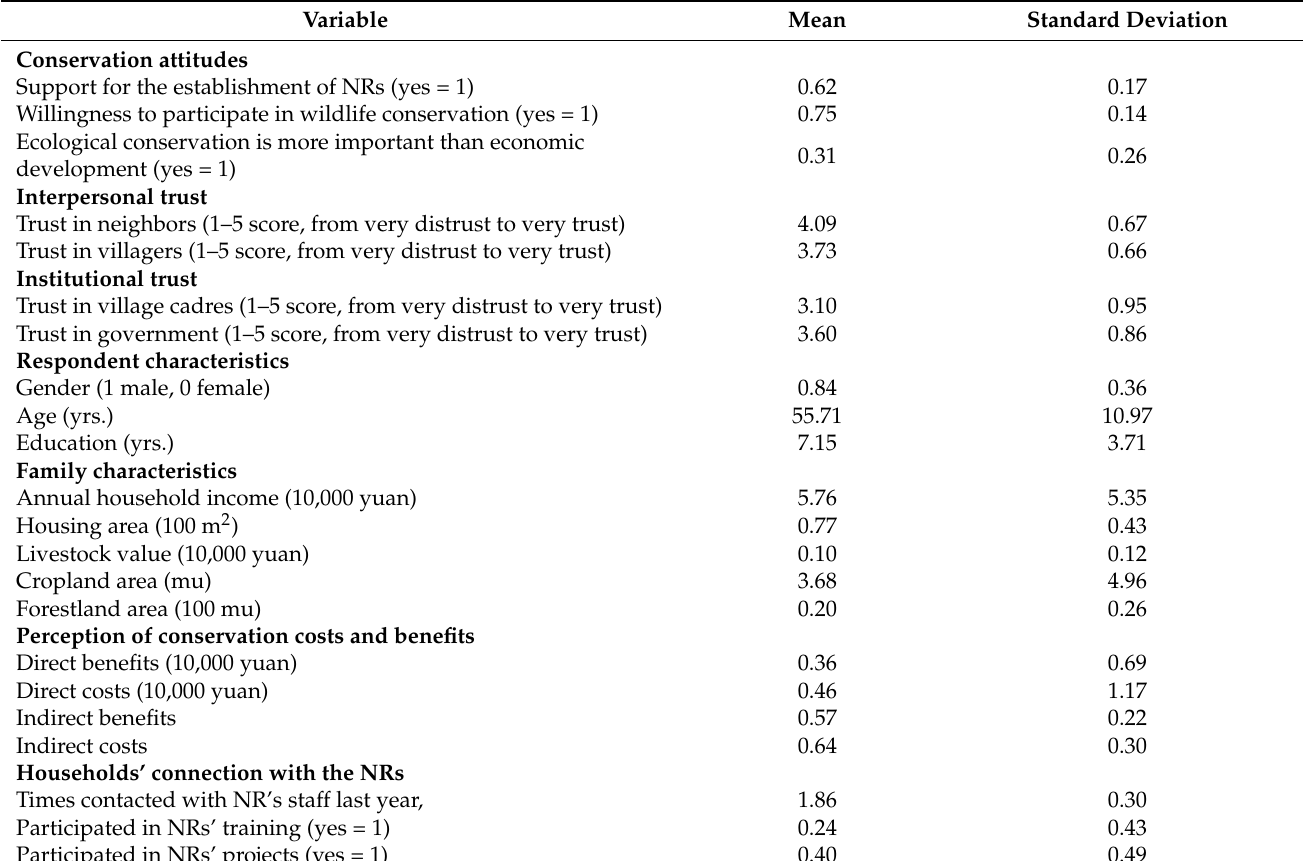
Table 1. Descriptive statistics of